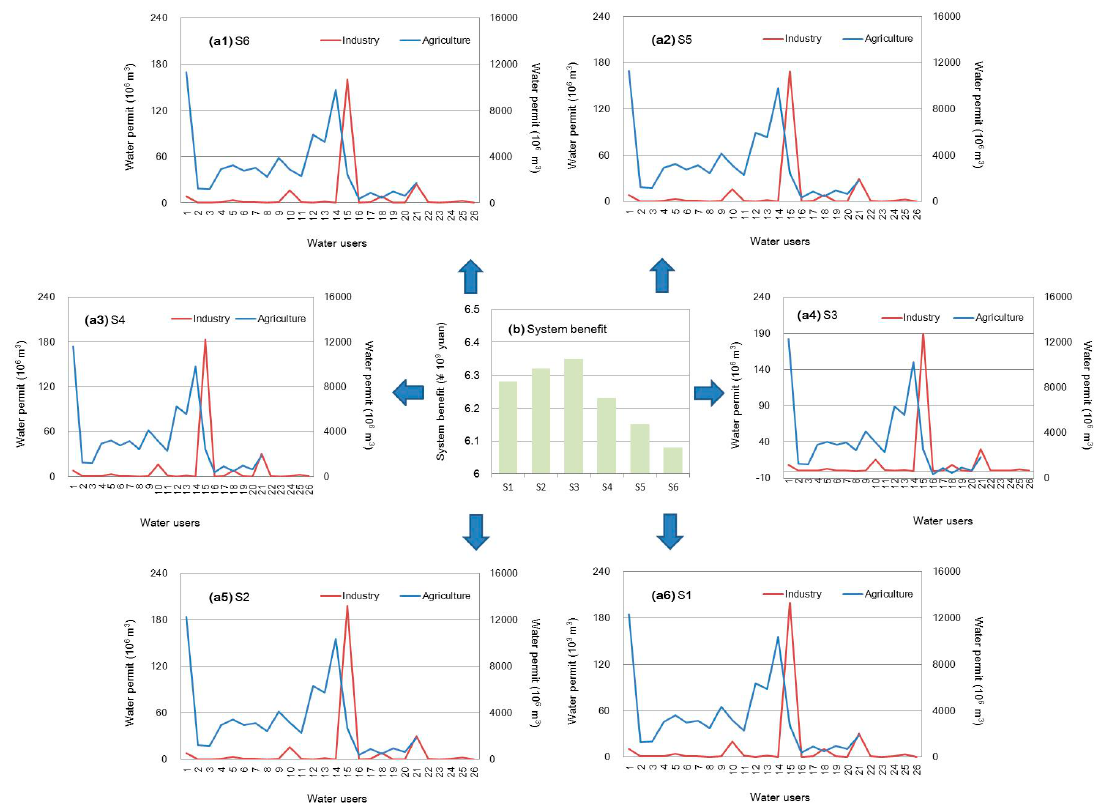
Figure 11. Optimal water-rights allocations and corresponding system benefits under various scenarios ( α = 0.6).